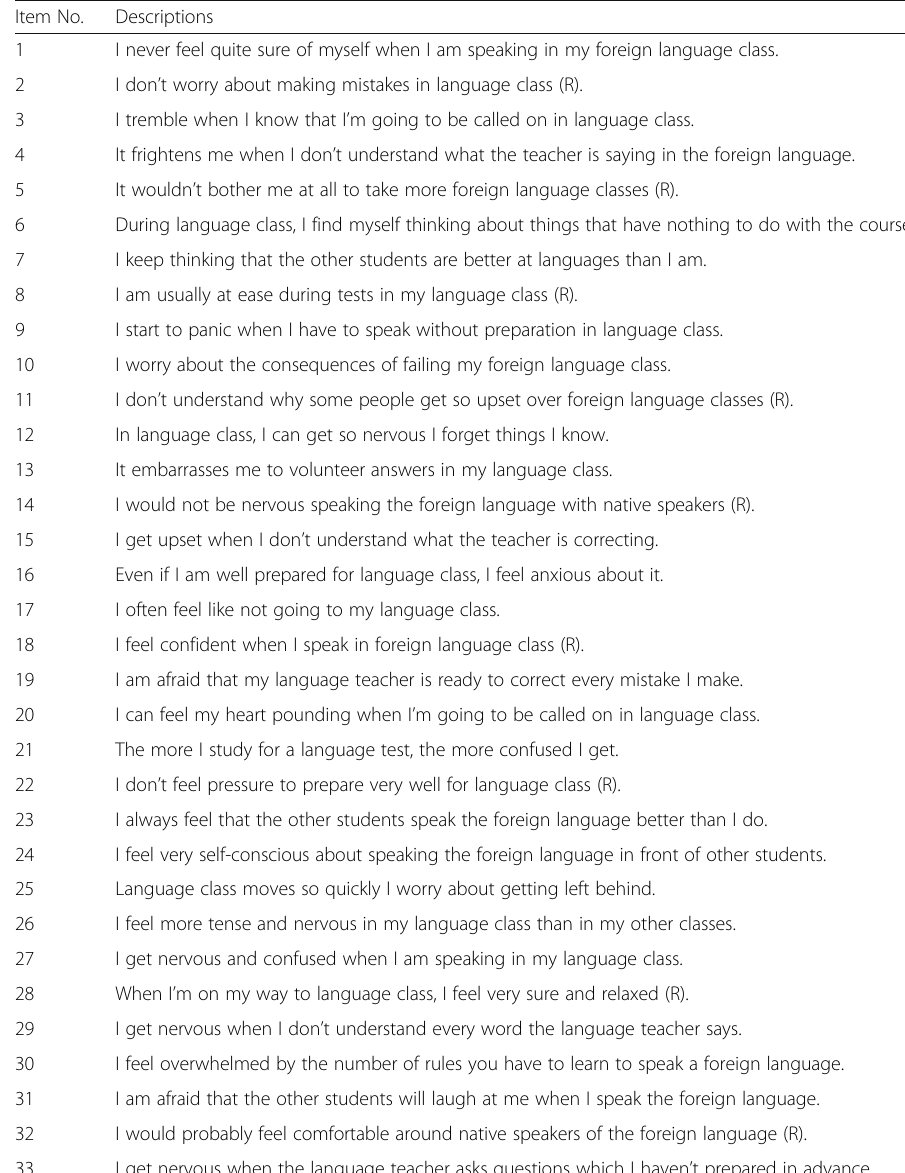
Table 8 Foreign Language Classroom Anxiety Scale (Horwitz et al. 1986) Item